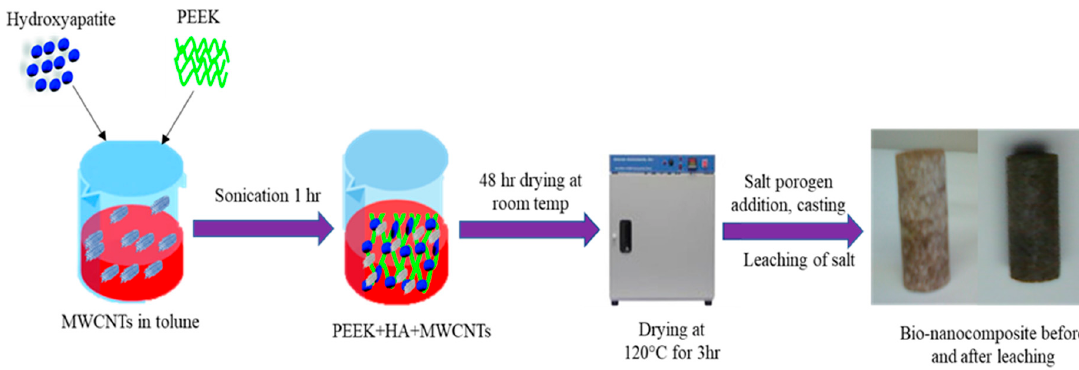
Figure 7. Schematic of PEEK / HA / CNT bionanocomposite synthesis process for biomedical